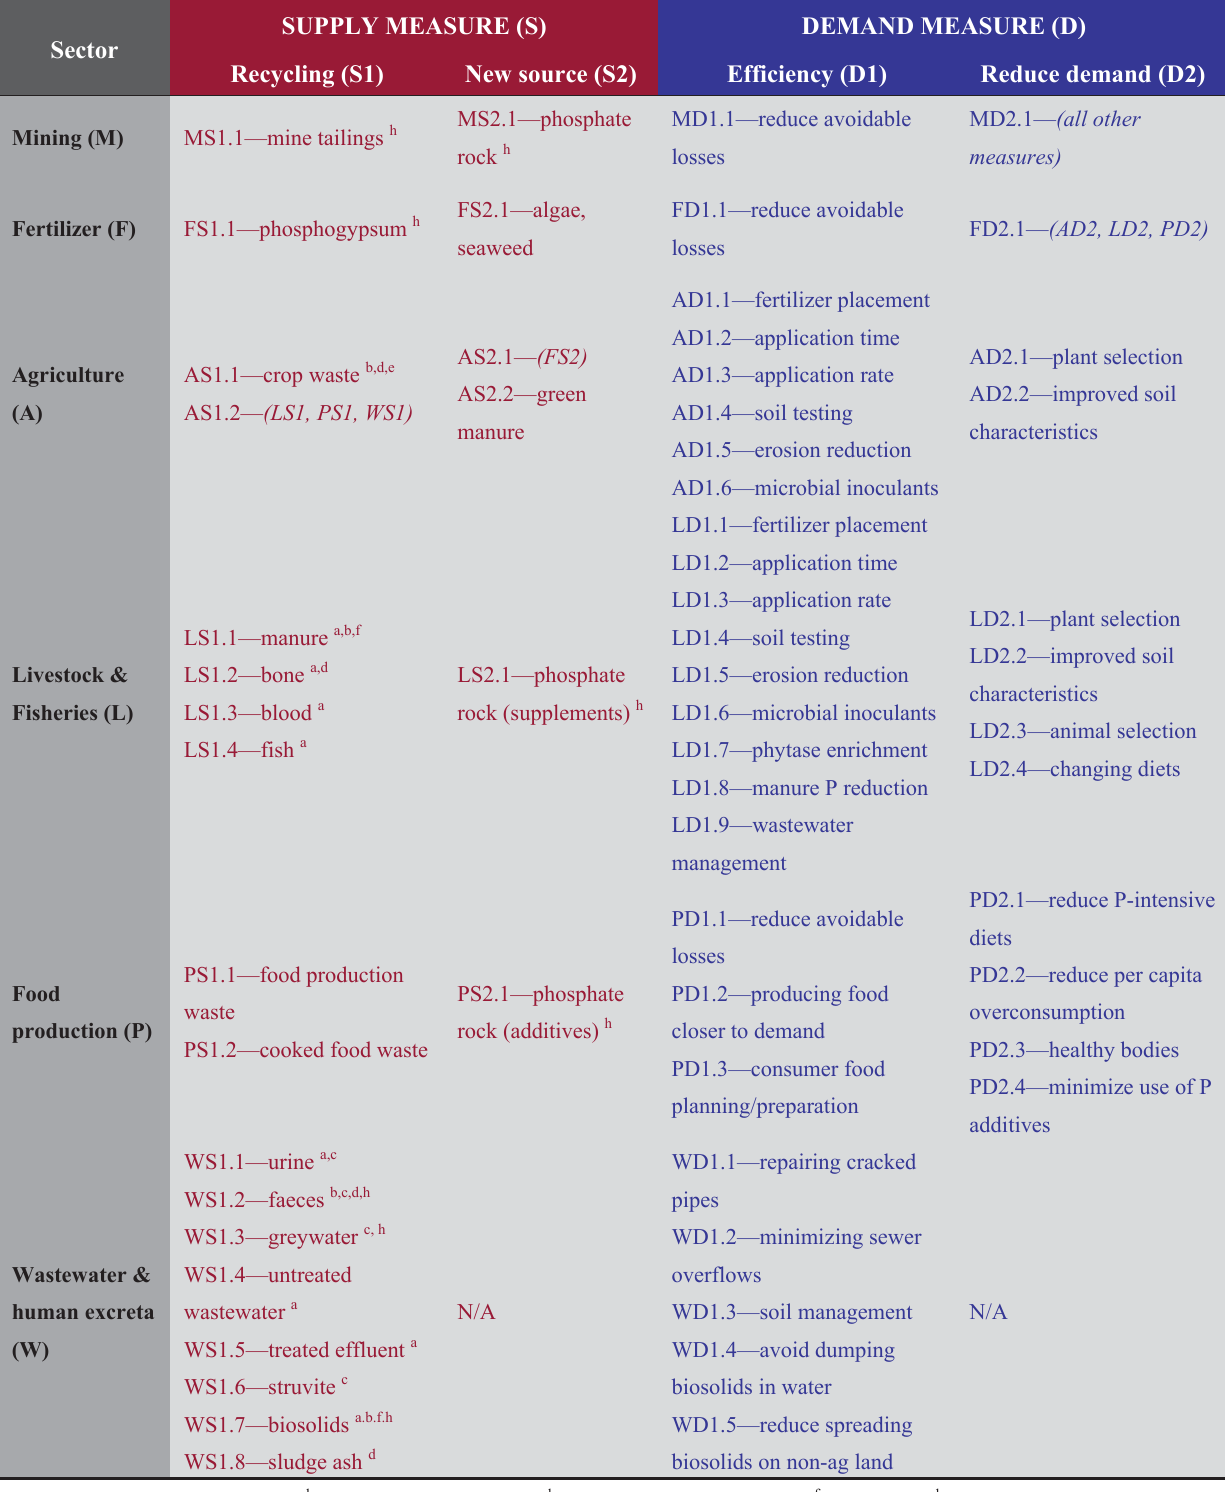
Table 2. Toolbox of sustainable phosphorus measures classified as supply and demand measures and by